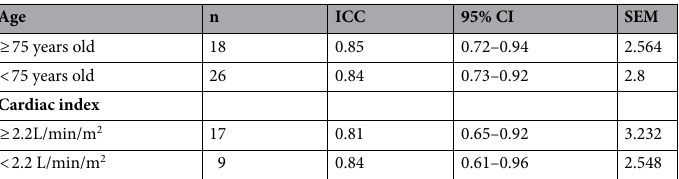
Table 3. subgroup analysis. ICC: intraclass correlation coefficient, 95%CI: 95% Confidence Interval, SEM: standard error of the measurement, CI: cardiac